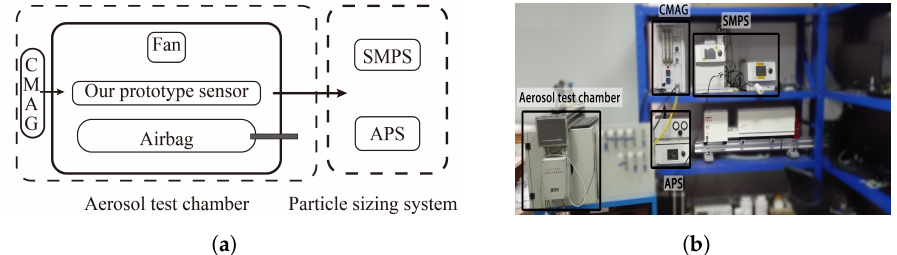
Figure 5. The experimental platform. ( a ) Block diagram of aerosol chamber and particle sizing system. ( b ) Photograph of aerosol samples testing system and aerosol sizing